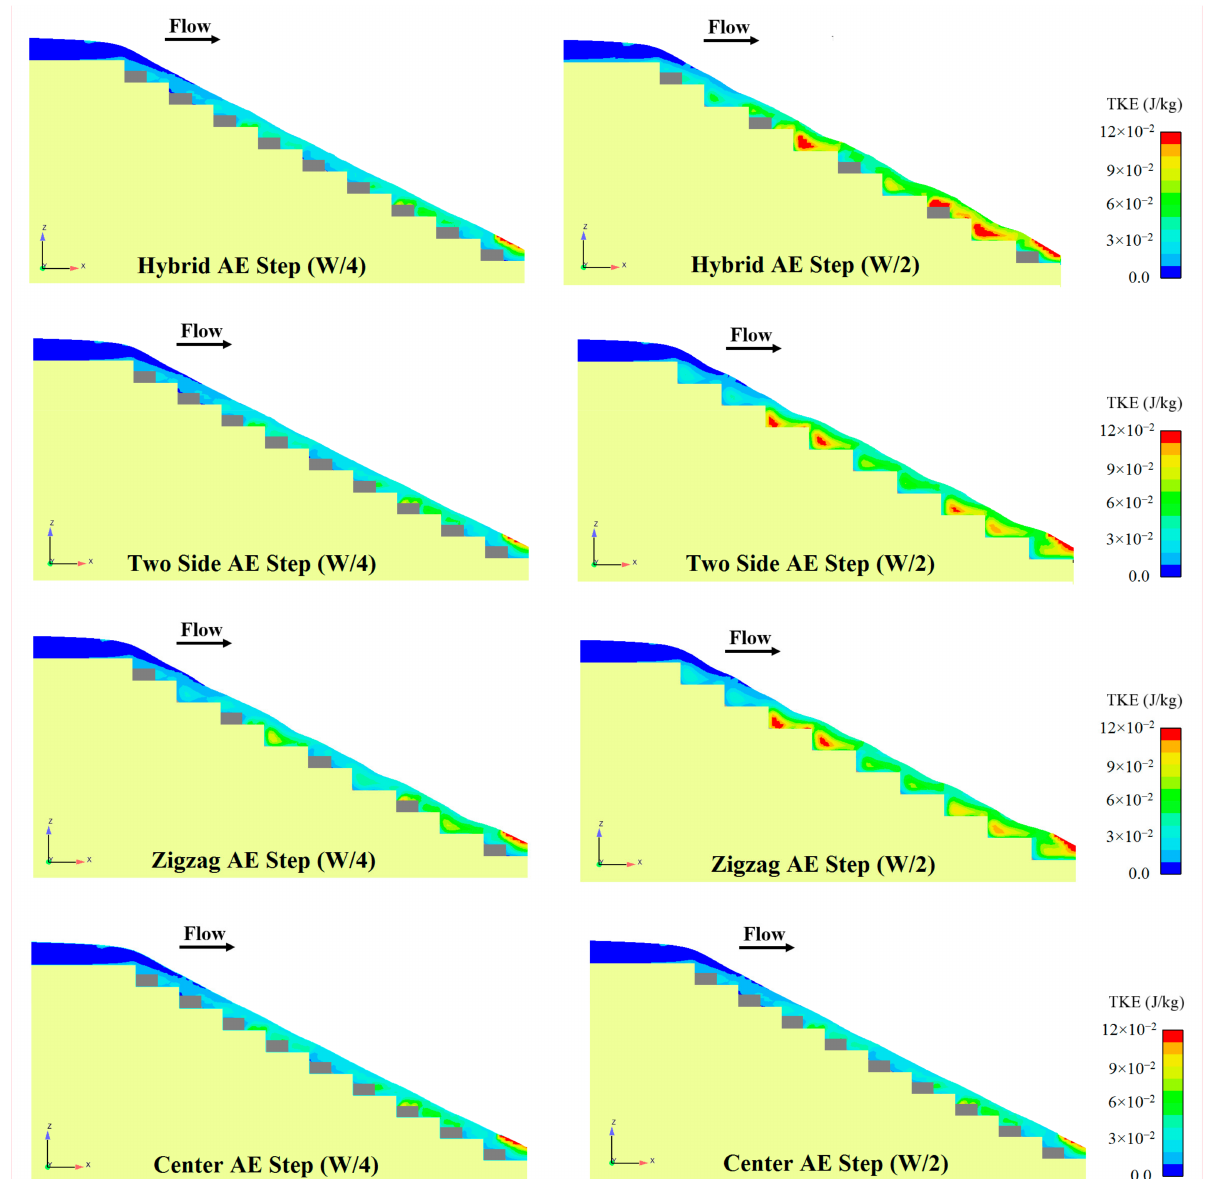
Figure 17. TKE values for different arrangement steps for discharge Q = 0.045 m 3